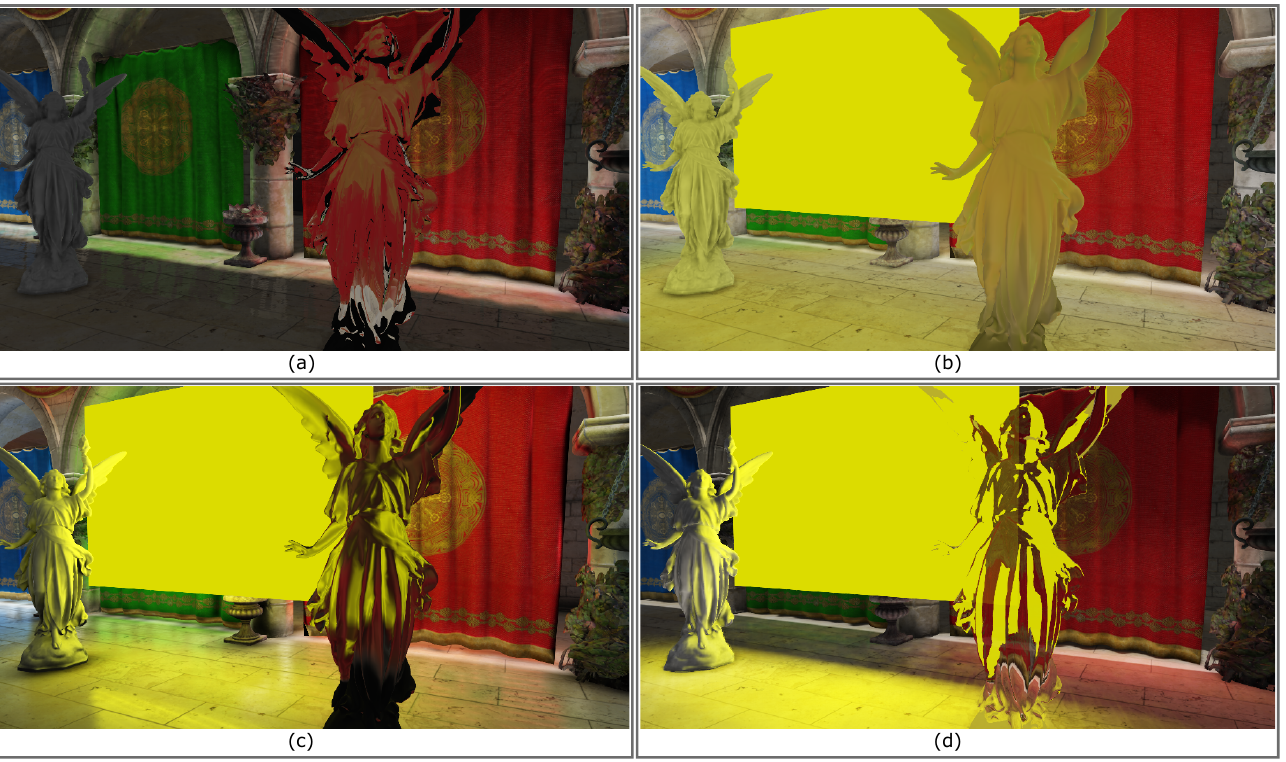
Figure 5. Diffuse indirect illumination, glossy reflections, subsurface scattering, translucency and direct illumination for area light sources implemented for different classes of methods for real- time global illumination. Panel ( a )—RSM-based methods; Panel ( b )—DOM-based methods; Panel ( c )—voxel-based methods; Panel ( d )—screen space methods. Table 1. Parameters that can be modified in real time provided by the